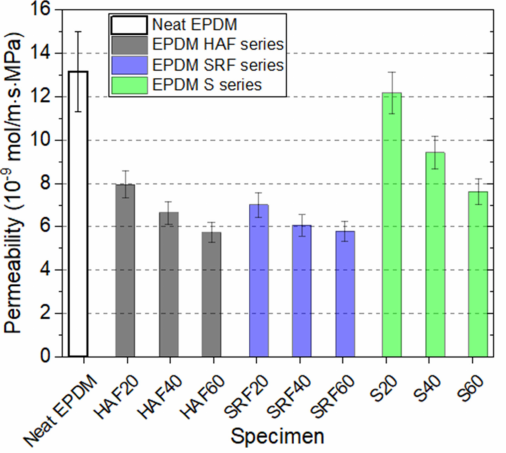
Figure 8. Permeability of neat EPDM and filled EPDM composites.